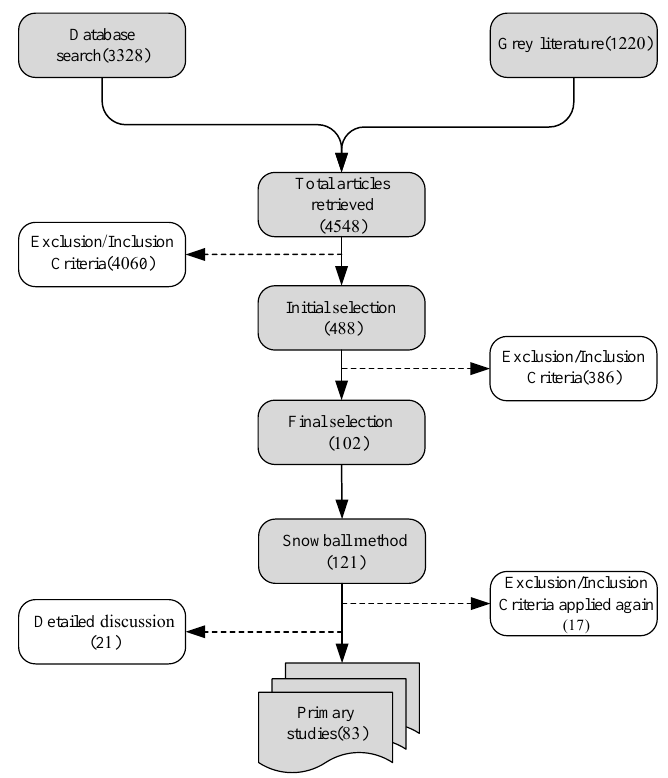
Figure 3. The process of primary study